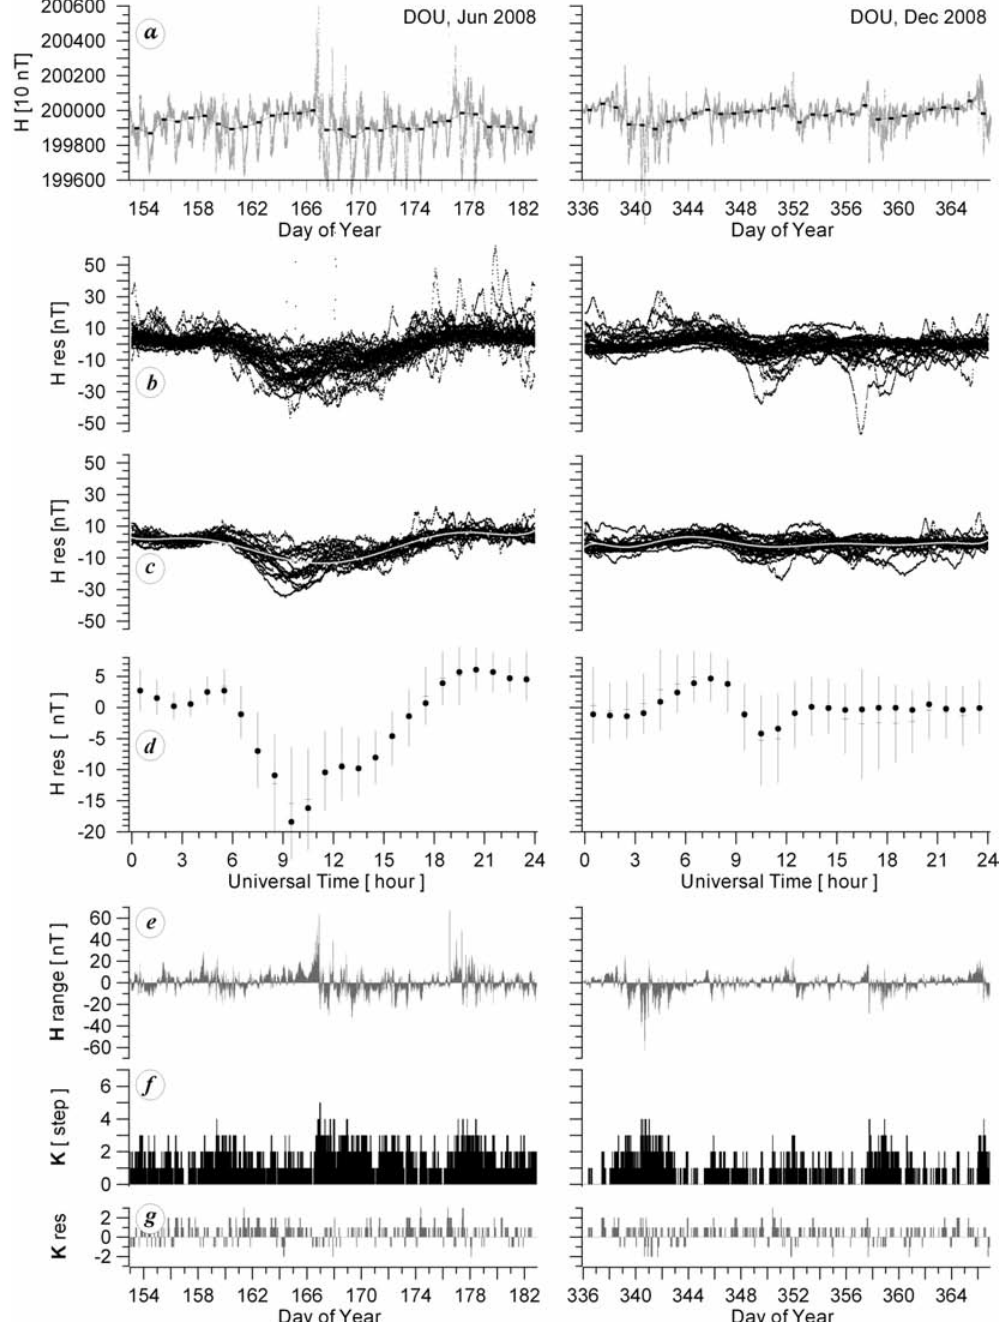
Figure 2. Calculations of the K index in real time demonstrated on 1-min digital magnetogram records from June, 2008 (left panels), and December, 2008 (right panels), for the Dourbes station. (a) Raw 1-min measurements of the H component. (b) H diurnal variations (relative, with daily medians removed). (c) H diurnal variations (relative, cleaned) during quiet days (K<3) only. (d) median (solid circles), mean (+) and standard deviations (vertical bars) of the diurnal variations (relative, quiet days). (e) Observed H component deviations from the SR curve (SR not shown: approximated through medians in (d)). (f) Calculated K index. (g) Residual errors (Kres), i.e. Kest minus